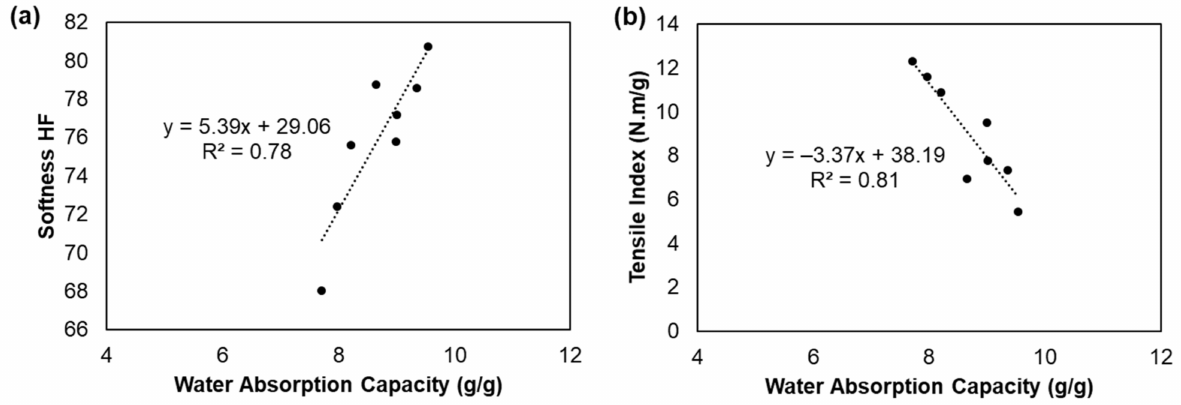
Figure 10. Correlation between the water absorption capacity and softness HF ( a ) and tensile index ( b ) of the tissue formulations.